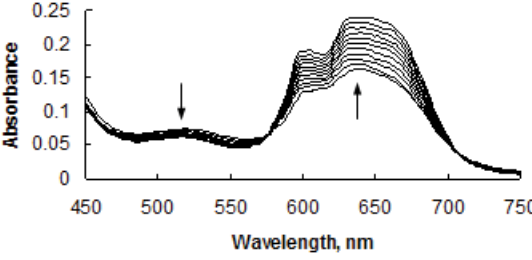
Figure 2. Absorbance changes during the trans -[Co(py)